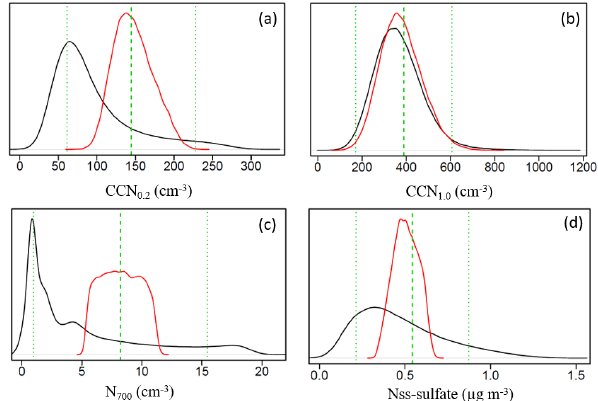
Figure 2. Unconstrained (black) and observationally constrained (red) pdf’s of aerosol properties: (a) CCN 0 . 2 , (b) CCN 1 . 0 , (c) N 700 and (d) aerosol sulfate. The pdf’s were calculated at locations where measurements were used for constraint across the months Decem- ber to March. Densities for each sample of model variants are scaled so that the area under the curve integrates to 1. The green dashed line shows the median of the measurements, and the dotted green lines show the approximate uncertainty ranges due to multiple model–measurement comparison uncertainties that were accounted for in the constraint (see Sect.